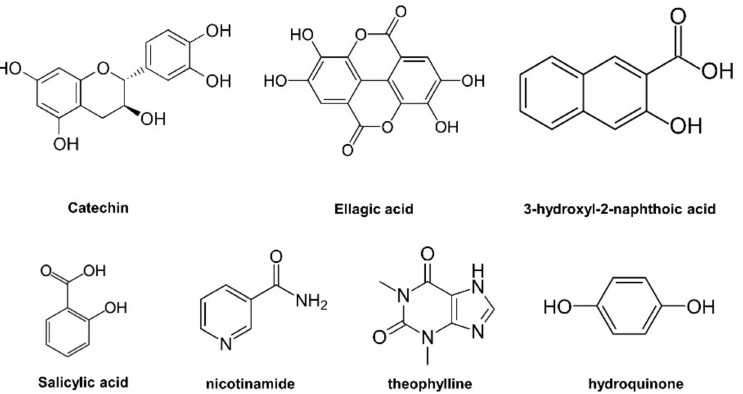
Figure 1. Chemical structure of the active pharmaceutical ingredients used in our screen which form cocrystals with